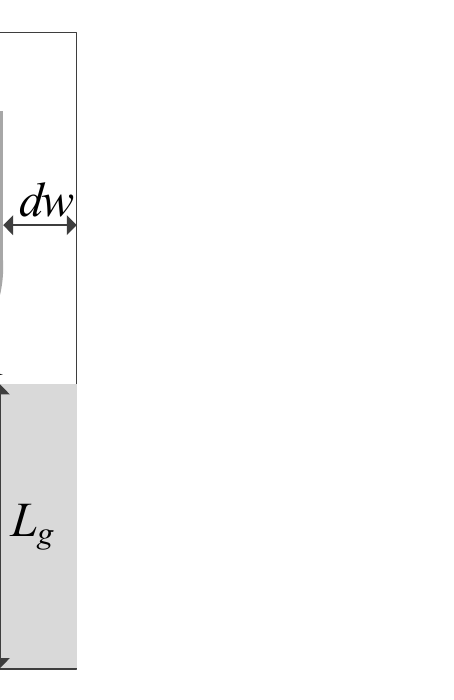
( b ) Figure 5. Antenna I: representative run of the proposed algorithm with automated adjustment of the penalty factors: ( a ) reflection coefficient at the initial (- - -) and optimized design ( — ); ( b ) evolu- tion of the penalty coefficient throughout the algorithm iterations. 4.3. Antenna II The second verification case is a broadband rectangular-slot monopole antenna (An- tenna II), shown in Figure 6 [37], operating in the UWB range. The design parameters of the antenna are x = [ L g L 0 L s W s d dL d s dW s dW a b ] T (all in mm). The feed line width is W 0